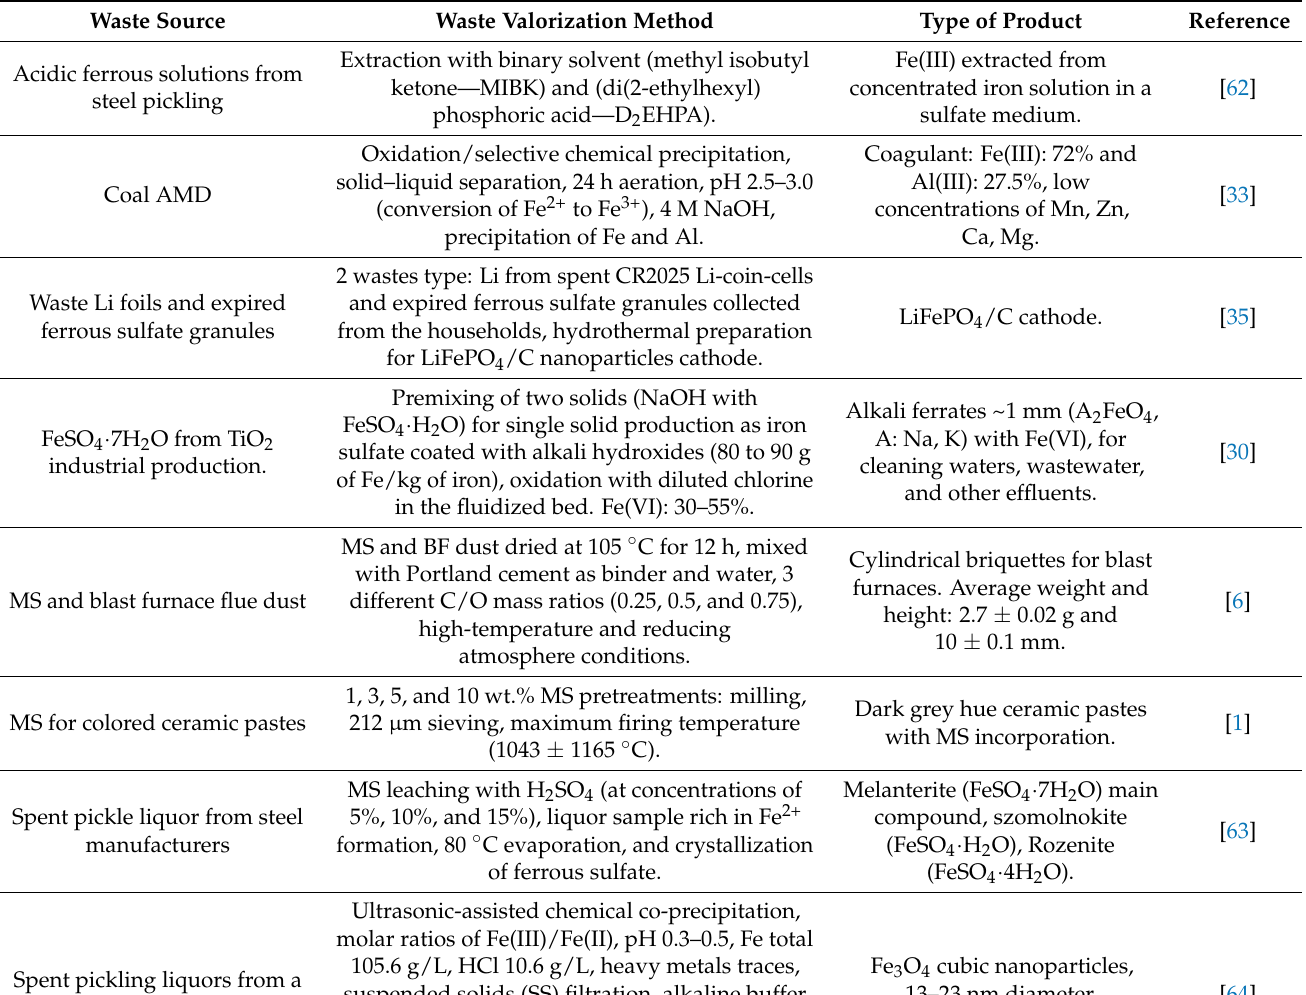
Table 1. Ferrous waste sources and the final products for industrial and water treatment